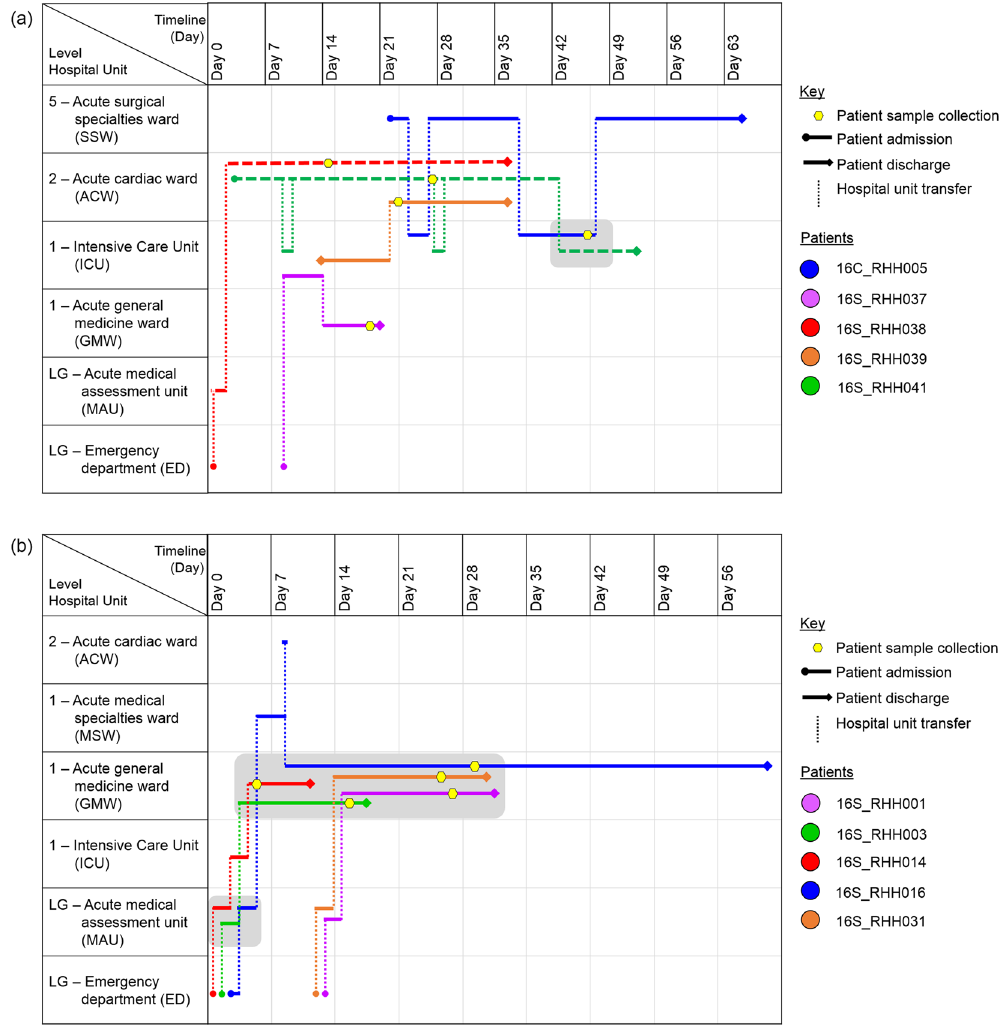
Figure 4. Spatio-temporal location of patients who tested positive for vancomycin-resistant Enterococcus faecium (VREfm) at the Royal Hobart Hospital. ( a ) Transmission of vanB ST796 VREfm from closely-related screening isolates belonging to Phylogenetic Clade 1 (PC1) to clinical patient 16C_RHH005. ( b ) Transmission of vanA ST80 VREfm among patients with isolates belonging to Phylogenetic Clade 2 (PC2). The movement line – screening patient; solid line – clinical